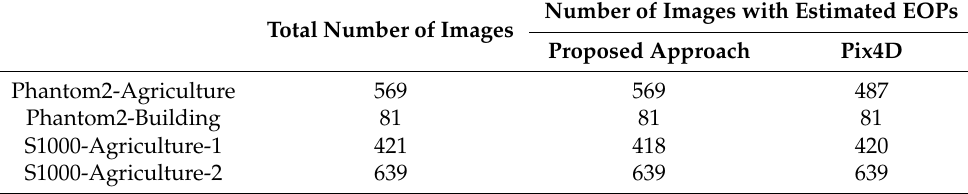
Table 4. Number of images with estimated EOPs for Phantom2-Agriculture, Phantom2-Building, S1000-Agriculture-1, and S1000-Agriculture-2